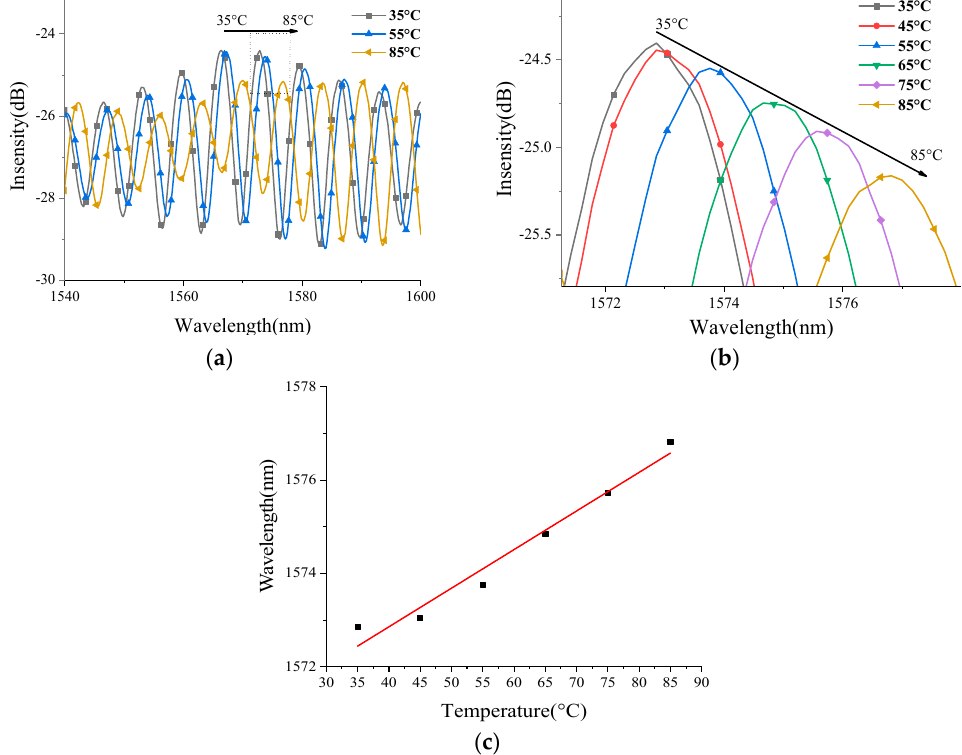
Figure 11. Temperature characteristics of sensor S2. ( a ) Spectrum range from 1540 to 1600 nm; ( b ) spectrum range from 1571 to 1578 nm; and ( c ) spectral peak sensitivity characteristics.